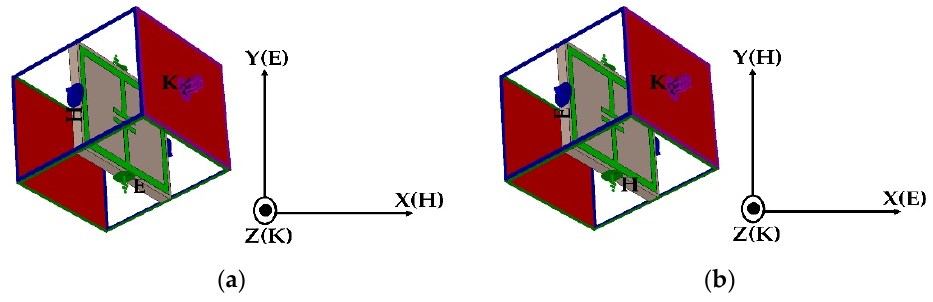
Figure 2. Simulation setup of the ELC unit cell. ( a ) Setup 1; ( b ) Setup 2.